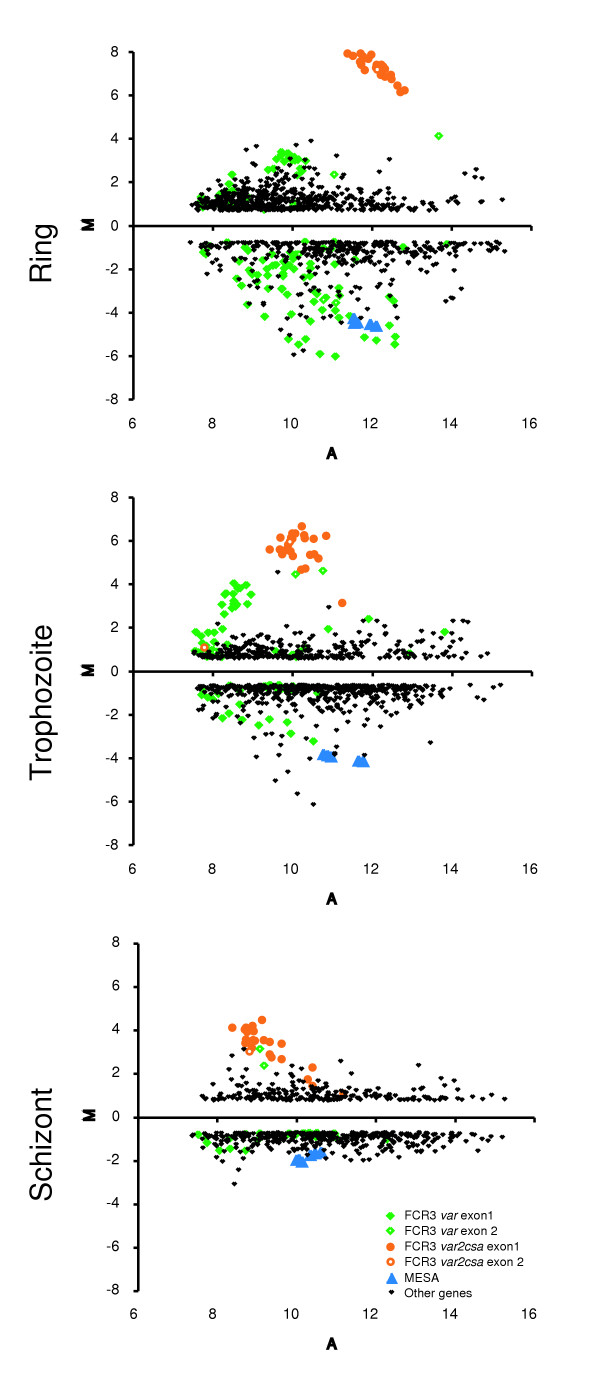
A dominant var gene is upregulated in CSA binding parasites. Plots of log2 ratio of expression (M) against average log intensity (A) for ring, trophozoite and schizont stages for CSA versus CD36 panned parasites. Only statistically differential data giving a Bonferroni corrected p value (alpha = 0.05) have been displayed. This graph excludes probes corresponding to antisense transcripts and oligos to 3D7 var genes (whose orthologs in FCR3 diverge in sequence). Biological replicates were pooled. The plots reveal a single dominant var transcript (var2csa-marked in orange) that is much more abundant in CSA than in CD36-panned parasites at all life stages. Green dots represent all other oligos corresponding to FCR3 var genes. Several var genes are over-represented in CD36 as compared with CSA-panned parasites. Both log2 ratios of expression and apparent average intensities for var genes decrease through the life cycle.